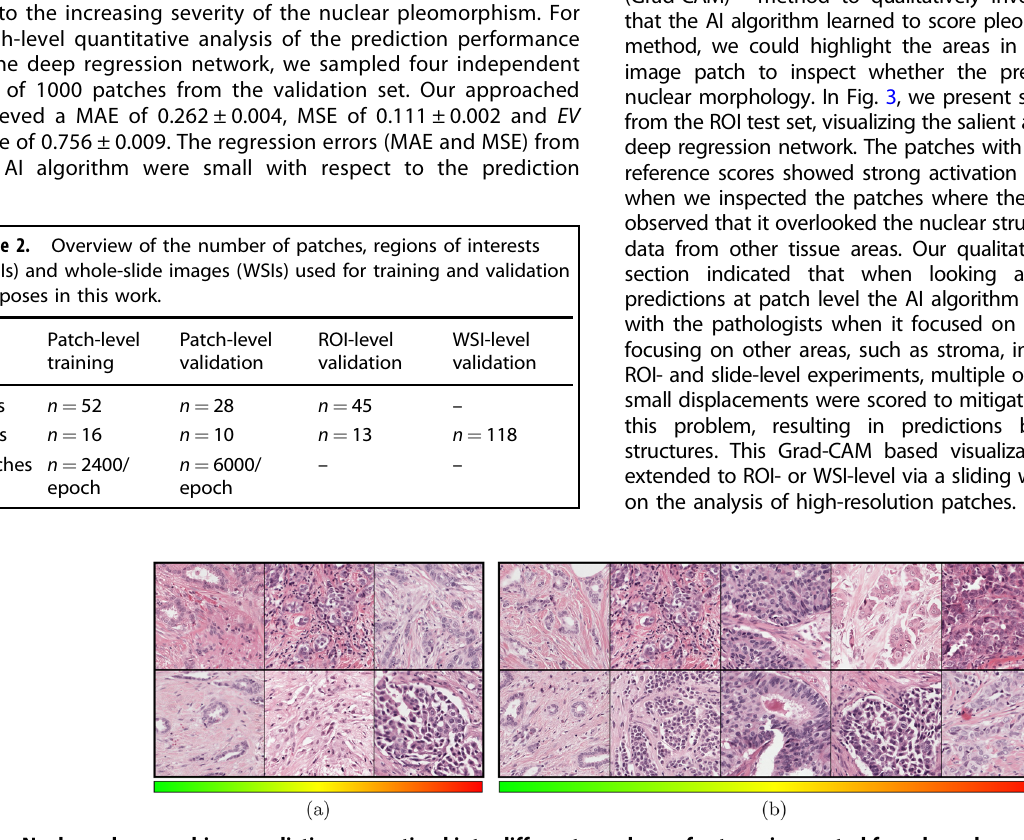
Fig. 2 Nuclear pleomorphism predictions quantized into different numbers of categories, sorted from low pleomorphism to high in each category, from left to right. In a , patches were quantized into three categories, which was in line with the three-category classi fi cation in routine clinical practice, whereas in b , the patches were quantized into fi ve categories to demonstrate the continuity of the nuclear pleomorphism spectrum from the predictions of the AI algorithm.